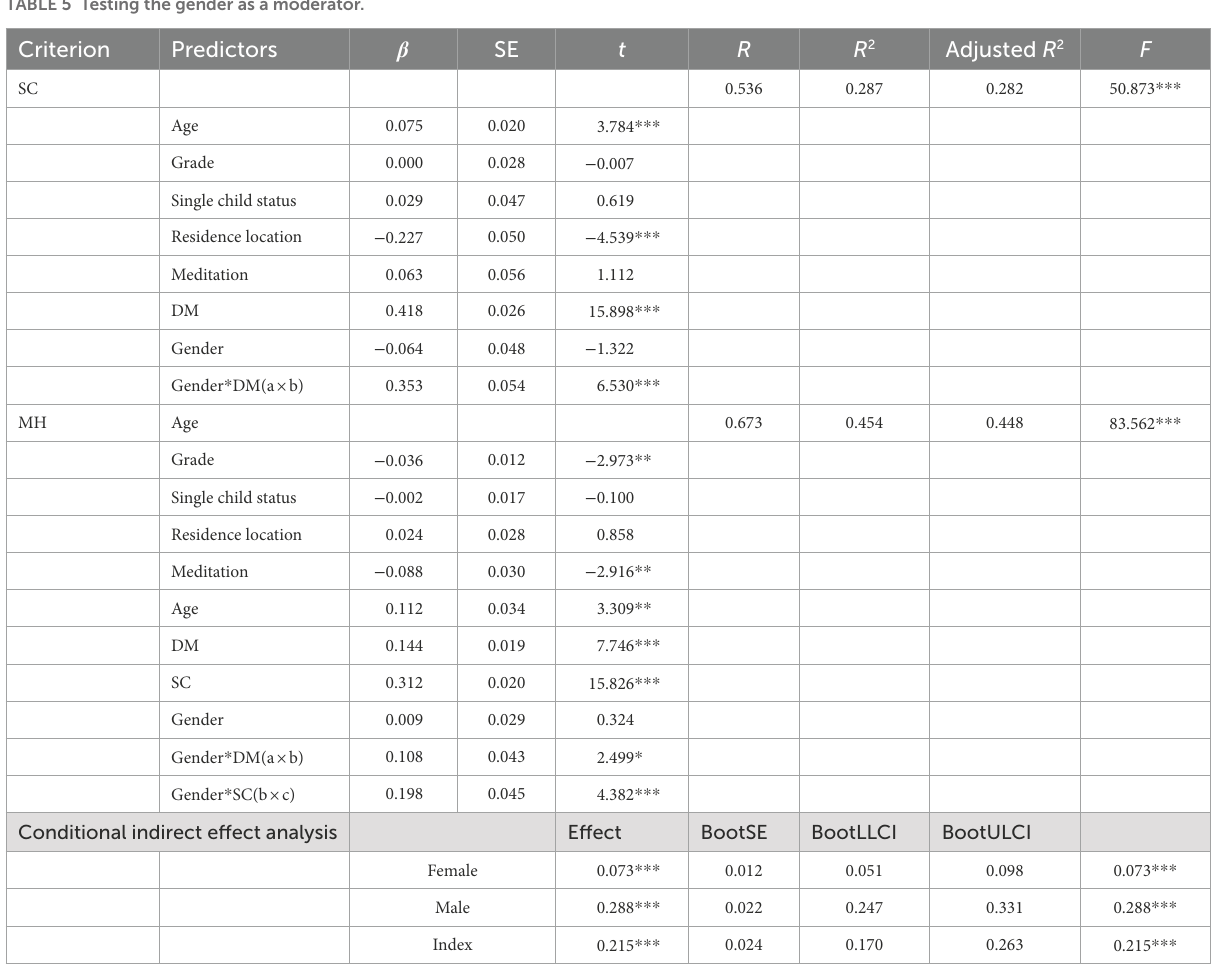
TABLE 5 Testing the gender as a moderator.